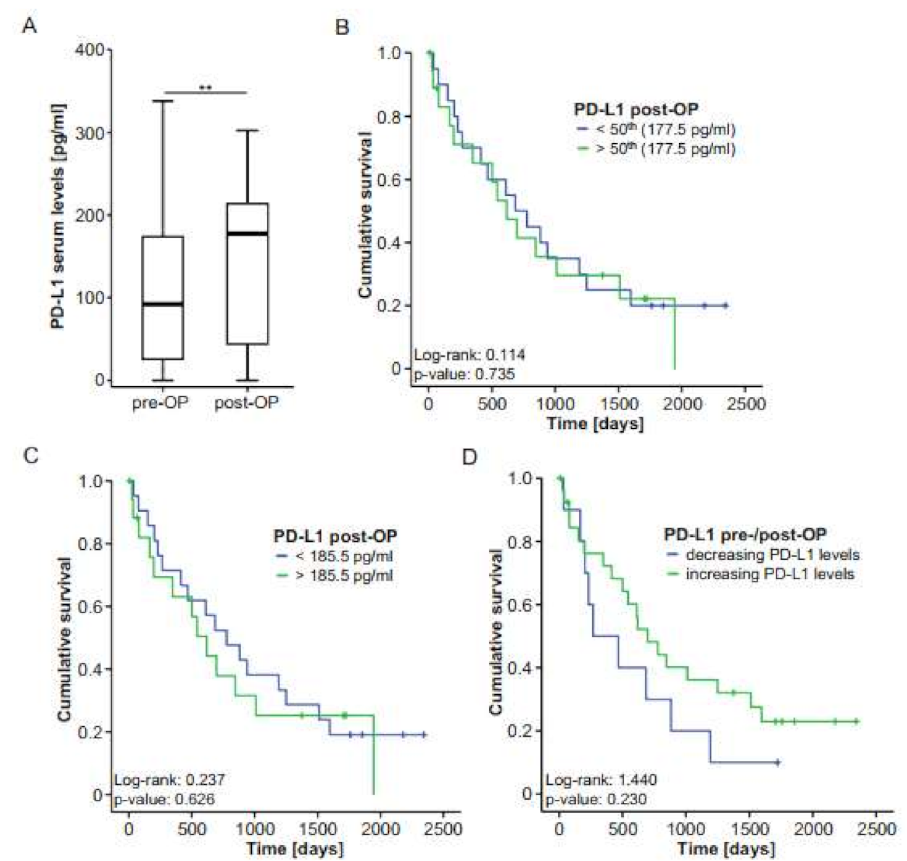
Figure 4. Postoperative PD-L1 levels do not predict outcome after BTC resection. ( A ) Postoperative PD-L1 serum levels are significantly higher compared to preoperative serum levels. ( B , C ) Kaplan– Meier curve analyses using the 50th percentile or the ideal prognostic cut-off value (185.5 pg/mL) reveal no survival benefit for patients with high or low PD-L1 levels. ( D ) BTC patients with decreasing PD-L1 serum levels after tumor resection show a nonsignificant trend towards an impaired survival. ** p <